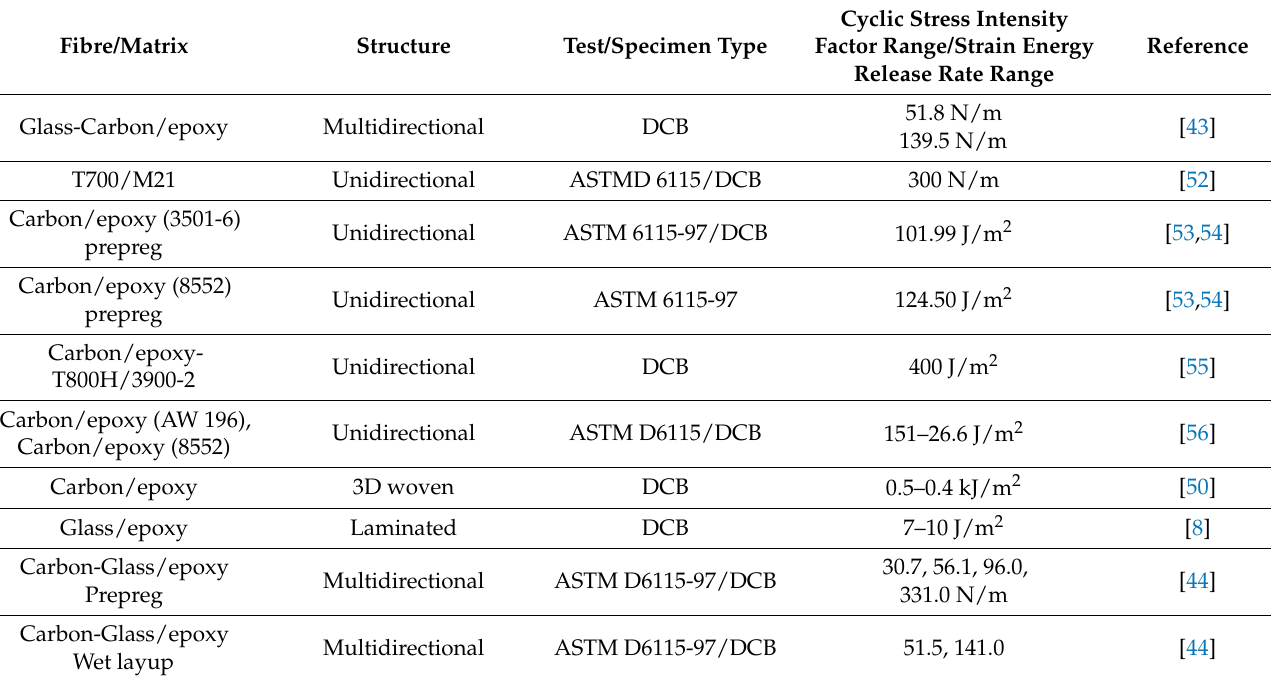
Table 1. Fatigue performance of glass/carbon fibre reinforced polymeric